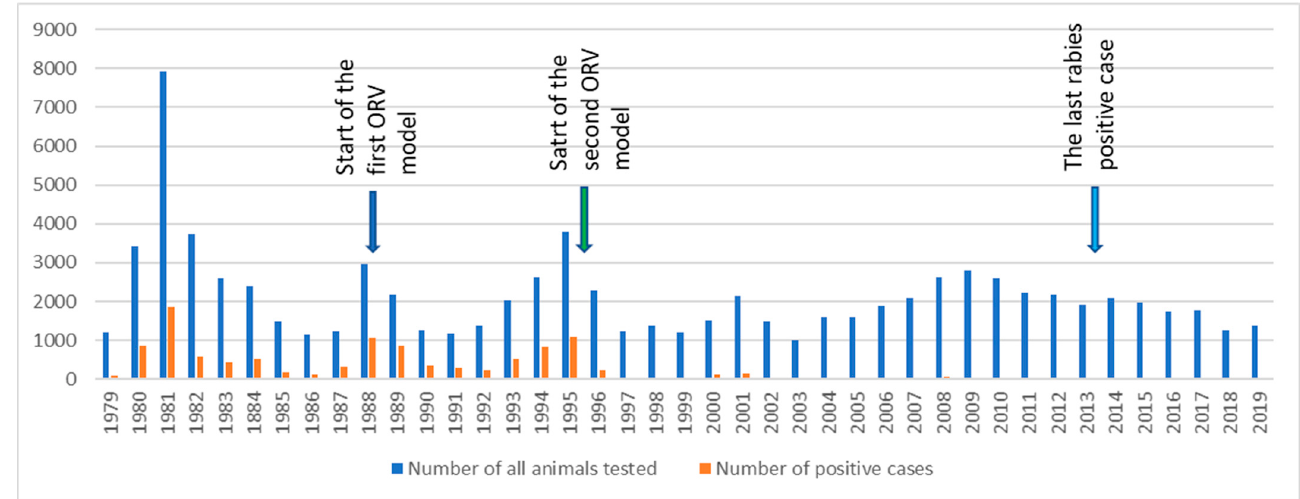
Figure 2. The number of tested animals (blue) and number of FAT-positive animals (orange) between 1979 and 2019 in Slovenia. The arrows show years with important dates: 1988, start of the first ORV model; 1995, start of the second ORV model; and 2013, the last sylvatic rabies case detected in Slovenia.